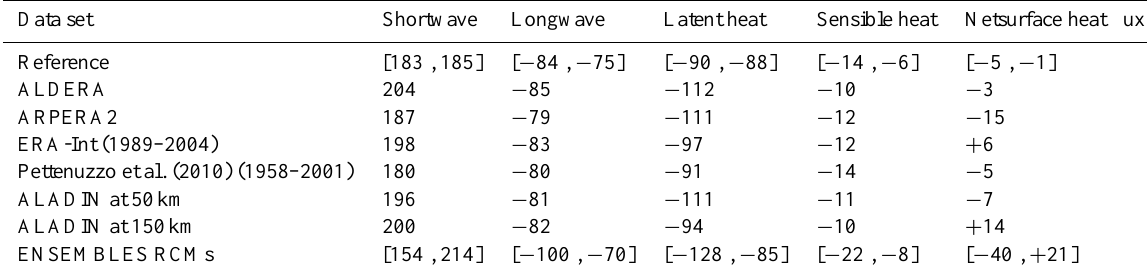
Table 1. Mediterranean Sea-averaged and temporal-averaged values of the various terms of the sea surface heat budget (Wm 2 ). Values are computed over the 1985–2004 period except for when indicated. The reference comes from Sevault et al. (2014). The so-called ENSEMBLES RCMs is an ensemble of 15 runs carried out with state-of-the-art RCMs during the EU project ENSEMBLES at 25km, driven by the ERA-40 reanalysis over the 1958–2001 period (see Sanchez-Gomez et al.,